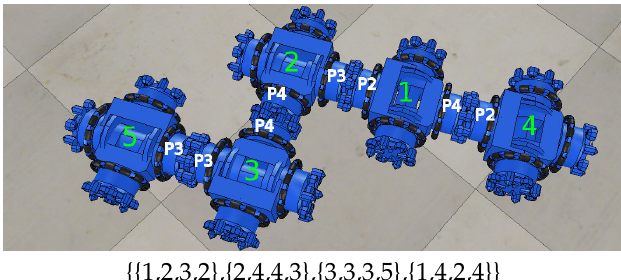
Figure 4. An example of how a Quadruplet array format converts to a robot structure. Robot Temporary ID numbers are shown in green, port numbers involved in docking are shown in white. The first Quadruplet states that the seed robot, with Temporary ID 1, is to recruit using its port 2 and call for port 3 of a robot to attach to it. This recruited robot is to identify itself with Temporary ID 2 once docked. Other Quadruplets specify other connections. These Quadruplets could be supplied in any order to define this